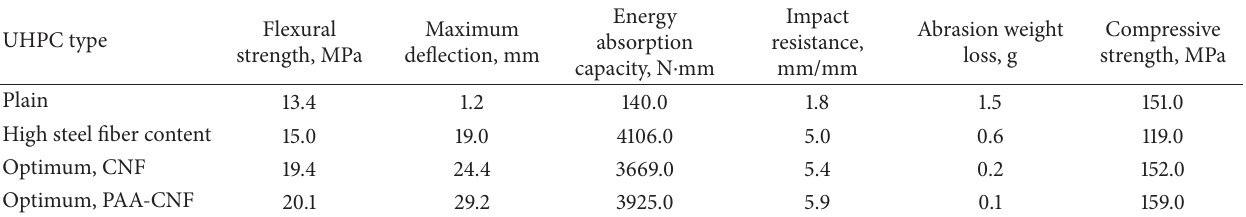
Table 3: Mean values of material properties for plain and optimally reinforced ultrahigh performance concrete (UHPC) materials and UHPC with a relatively high steel fiber content. UHPC type